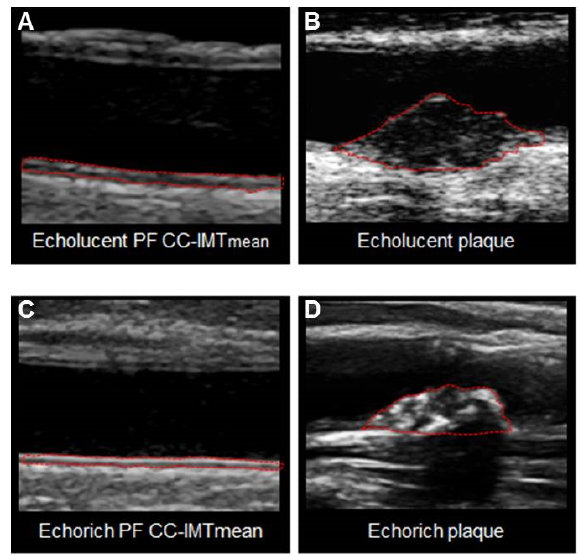
Figure 1. Examples of lesions with echolucent ( A , B ) and echo-rich ( C , D ) features of two types of carotid ultrasonographic images. Panels on the left show the echolucency features detected on the common carotid IMT, measured in plaque free areas (echolucency of PF CC-IMT mean ). Panels on the right show the same features detected on a carotid plaque (echolucency of plaque).